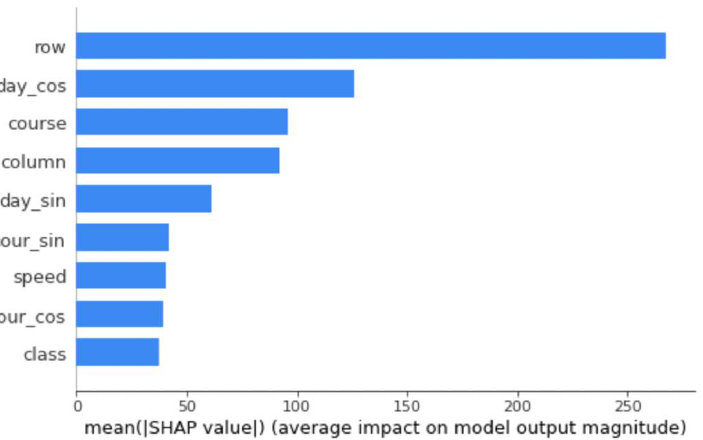
Figure 11. The average SHAP value for each input feature of the experiment for KNN.